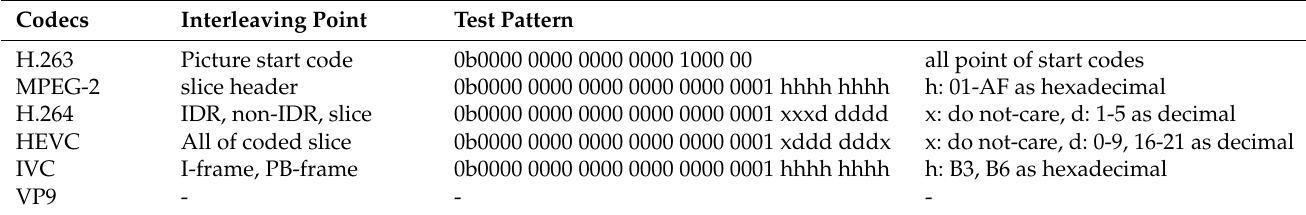
Table 1. Test pattern for the NALU parsing process of the proposed method.